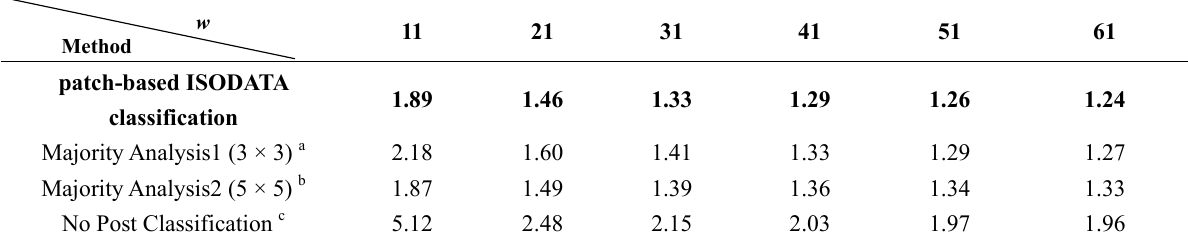
values of the different classification methods for unmixing MOD09GA Table 4. ERGAS H images from 8 October 2002 with different sizes of sliding